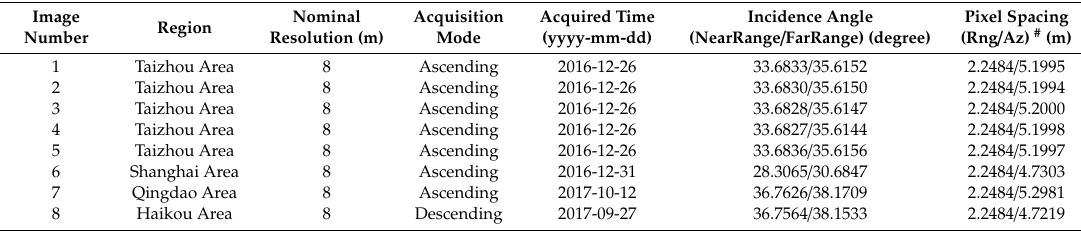
Table 2. The information about the Gaofen-3 images employed in the experiment.